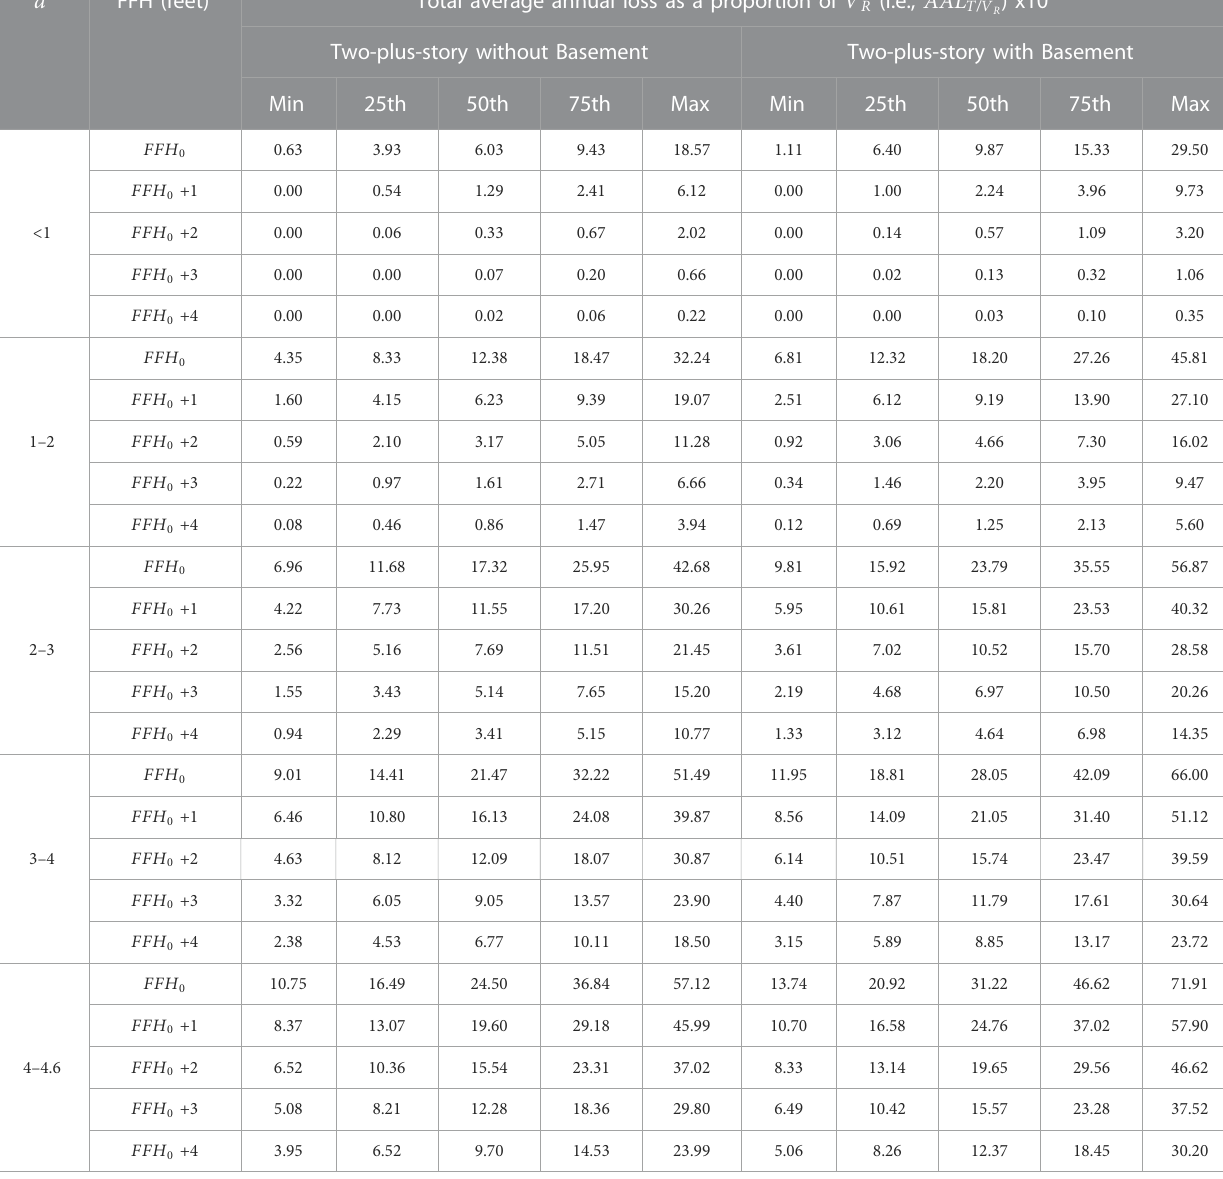
TABLE 6 As in Table 4 but categorized based on a parameter. a FFH (feet)